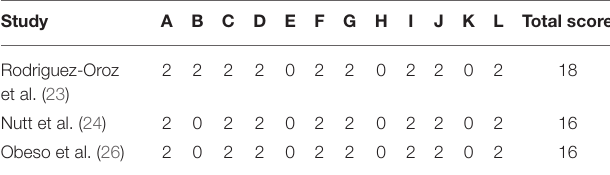
TABLE 2 | Risk of bias results assessed with methodological index for non-randomized studies (MINORS).